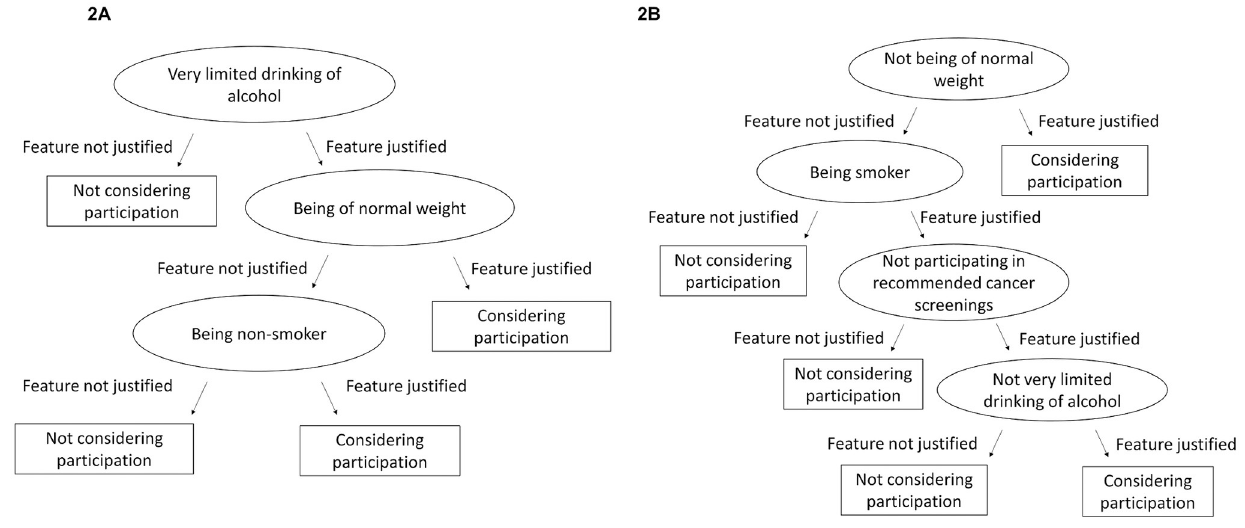
Fig 2. Fast-and-frugal decision trees (FFTs) for health scoring with bonus (A) and malus framing (B).